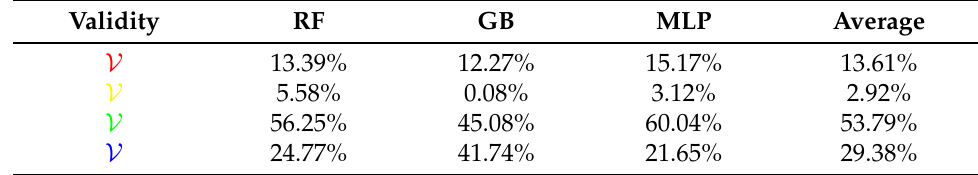
Table 8. Rate of validity of RHOASo vs. HPO across all D i (% with accuracy and time complexity).